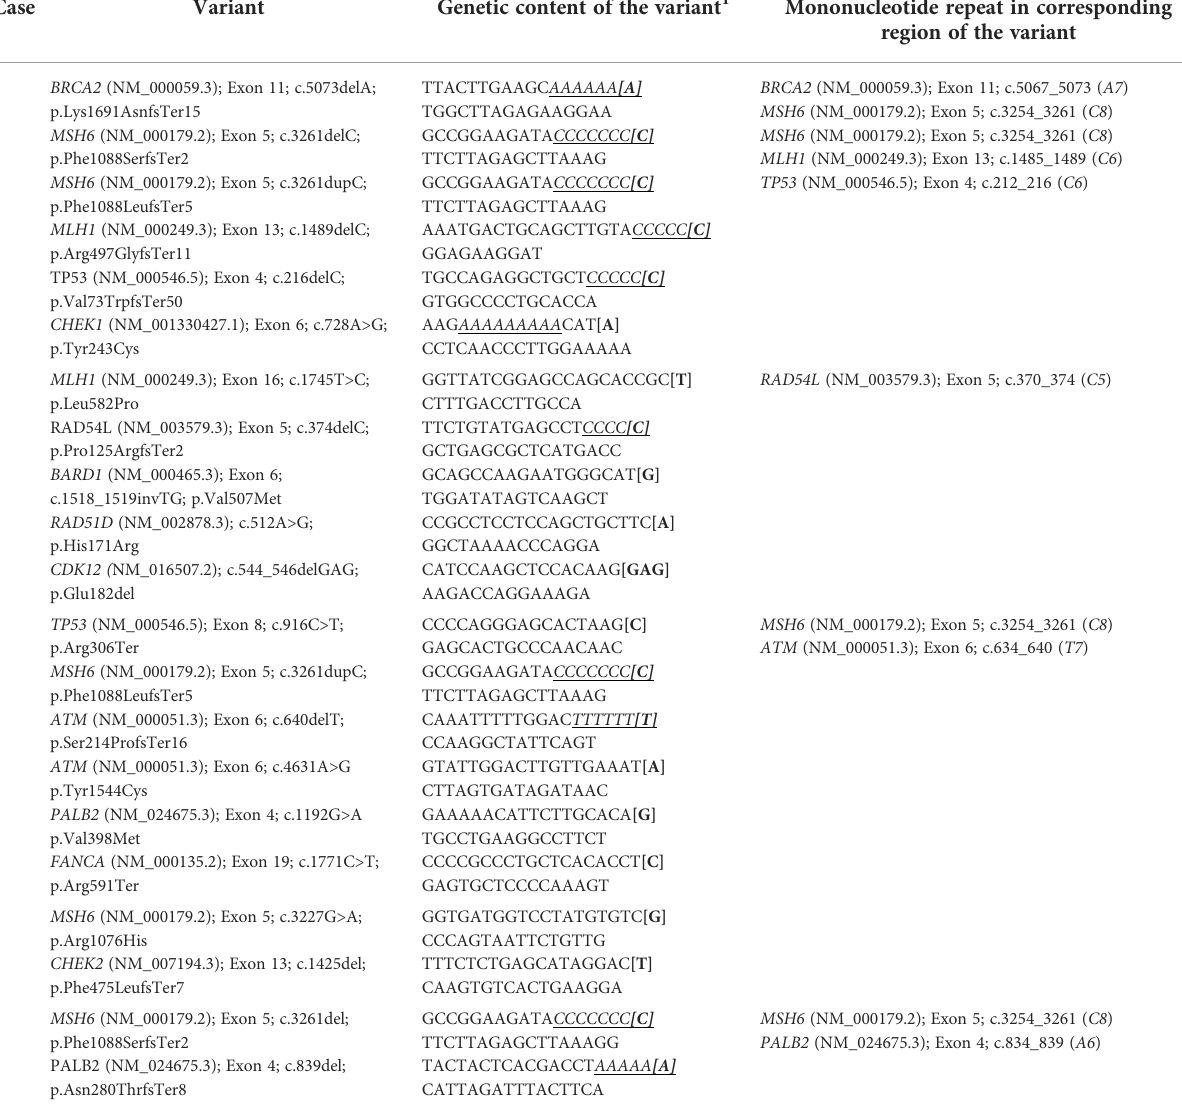
TABLE 4 Genetic content of identi fi ed variants regarding mononucleotide repeats in MLH1 - /PMS2 - /MSH6 - digestive system cancer cases. Variant Genetic content of the variant 1 Mononucleotide repeat in corresponding region of the